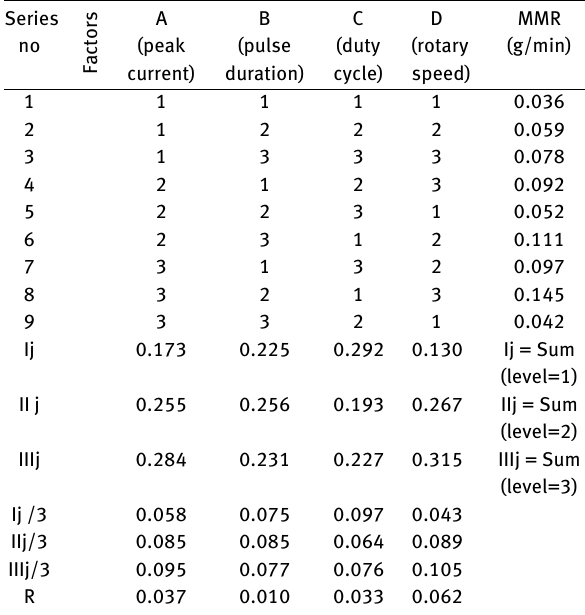
Table 3: Results of the orthogonal analysis on MRR of ECDGM.